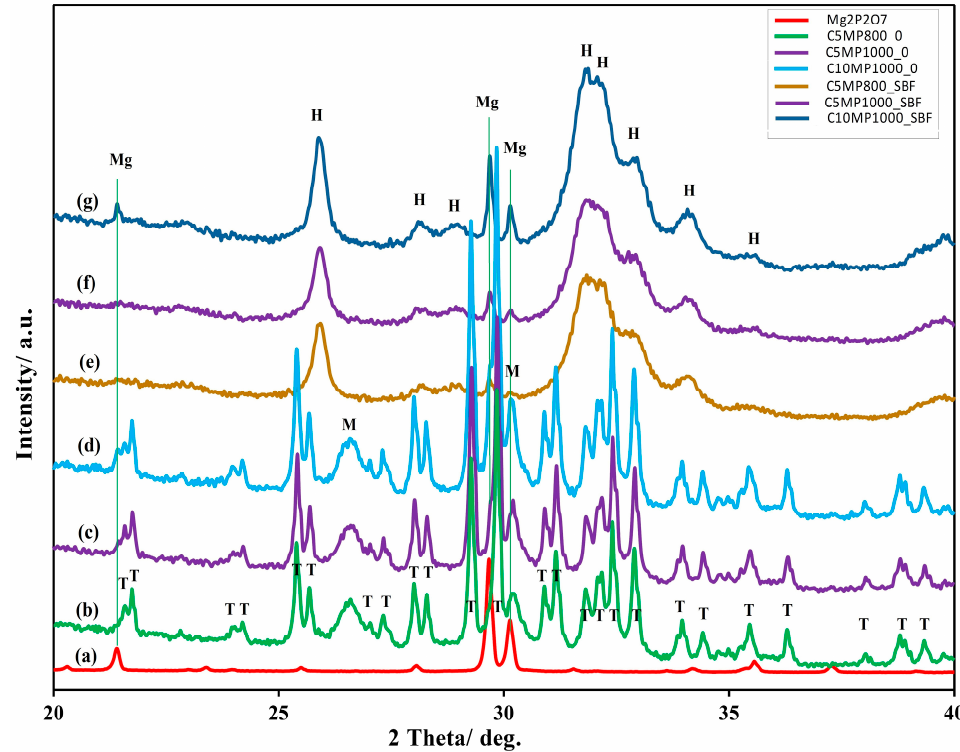
Figure 2. XRD patterns of origin cement powder mixtures and Mg 2 P 2 O 7 before (Mg 2 P 2 O 7 ( a ), C1MP850-0 ( b ), C1MP1000-0 ( c ), C2MP1000-0 ( d )), and after 7 days soaking in SBF at 37 °C (C1MP850-SBF ( e ), C1MP1000-SBF ( f ), C2MP1000-SBF ( g )). (Mg: Mg 2 P 2 O 7 (JCPDS 32-0626), H: hydroxyapatite (PDF4 01-071-5048), M: monetite (JCPDS 09-0080), TTCP (JCPDS 25-1137)).